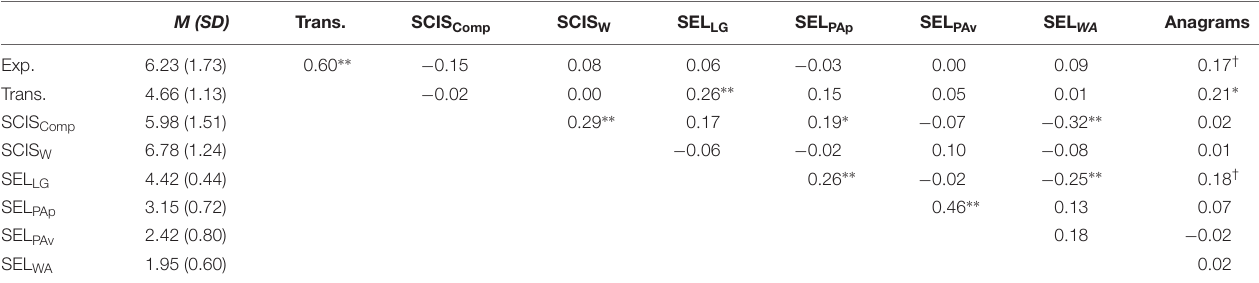
TABLE 1 | Correlations among variables and descriptive statistics (Study